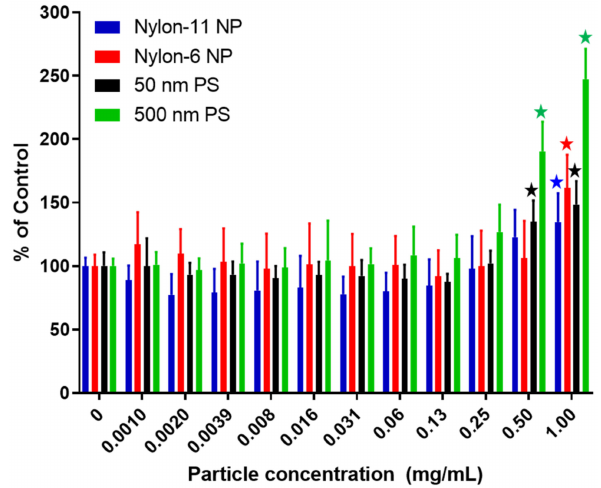
Figure 5. Cytotoxicity of 50 nm PS nanoparticles (black), 500 nm PS nanoparticles (green), nylon-11 NPs (blue), and nylon-6 NPs (red) after exposure to different doses of NPs for 24 h. The graphs show mean ± standard deviation. Significant difference between corresponding vehicle control and dose treatment is shown in stars for each particle. Two-way ANOVA showed that nanoparticle composition contributed to the